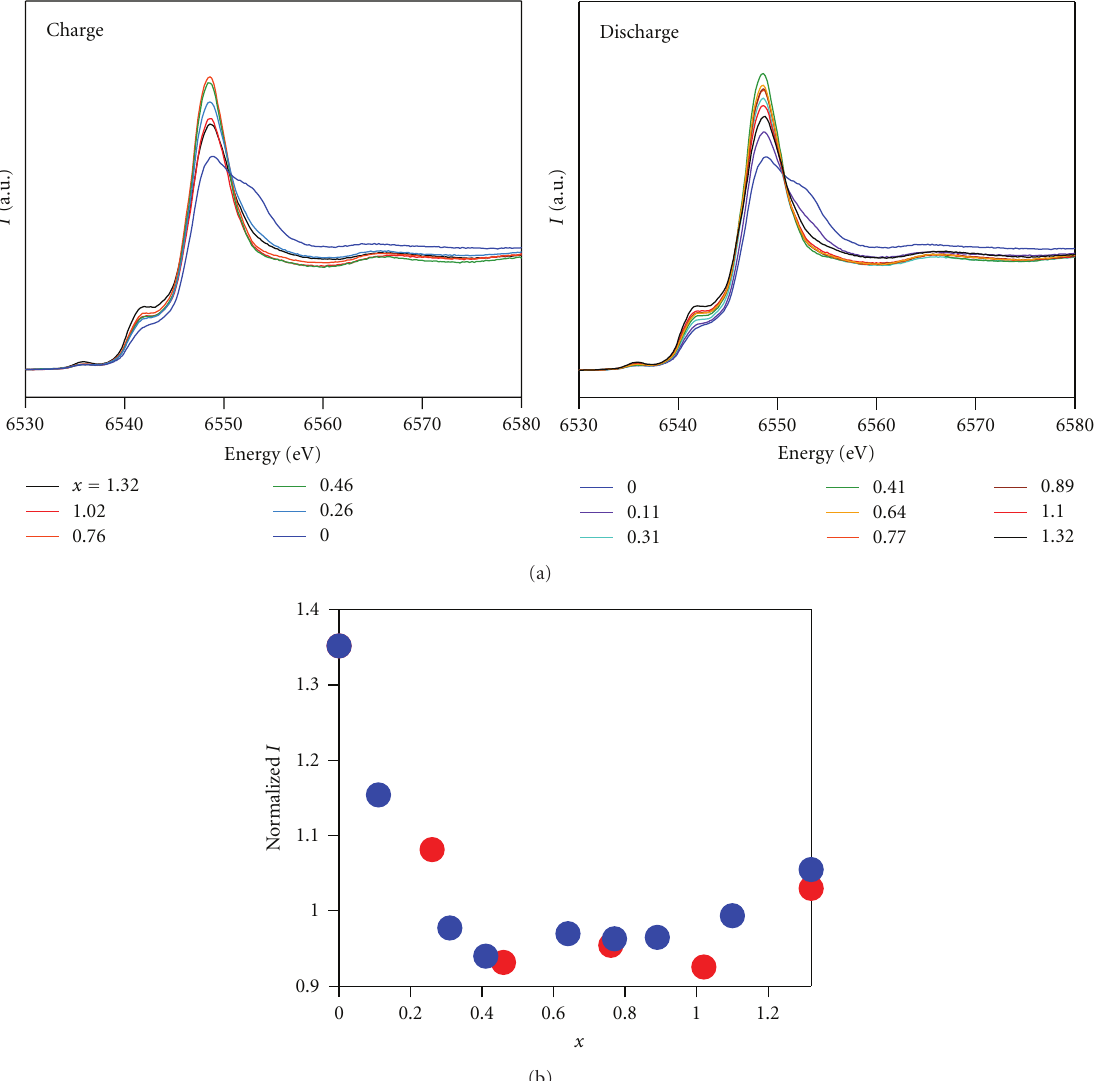
Figure 5: (a) Mn K-edge XAS spectra for the charge (left) and discharge (right) processes of film-type electrode of Li x Mn[Fe(CN) 3 . 5H 2 O. (b) Normalized intensity ( I ( x )) against x for the charge (red) and discharge (blue)